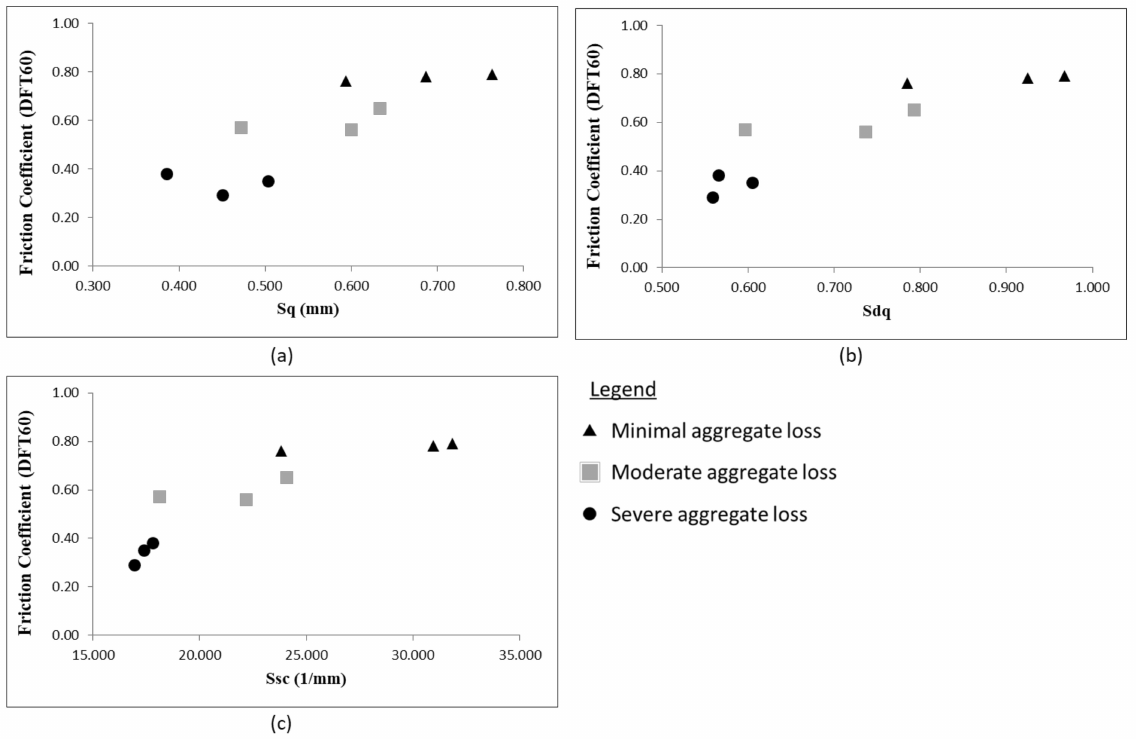
Figure 15. Relationship between DFT60 friction coefficient and parameters related to the aggregate characteristics including ( a ) root mean square height ( S q ), ( b ) mean quadratic slope ( S dq ), and ( c ) curvature ( S sc